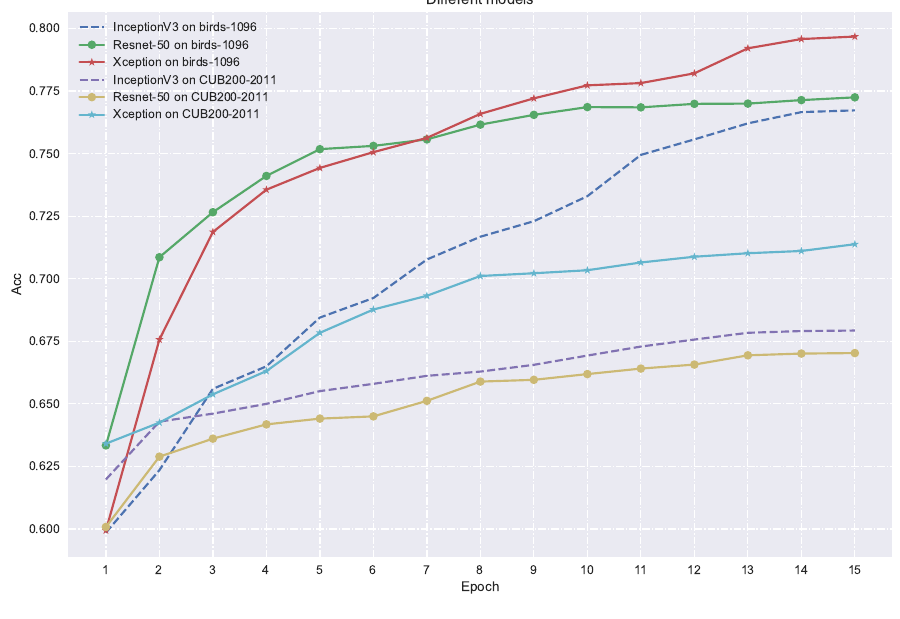
Figure 4. Acc curves of the evaluated basic networks trained on Birds-1096 and